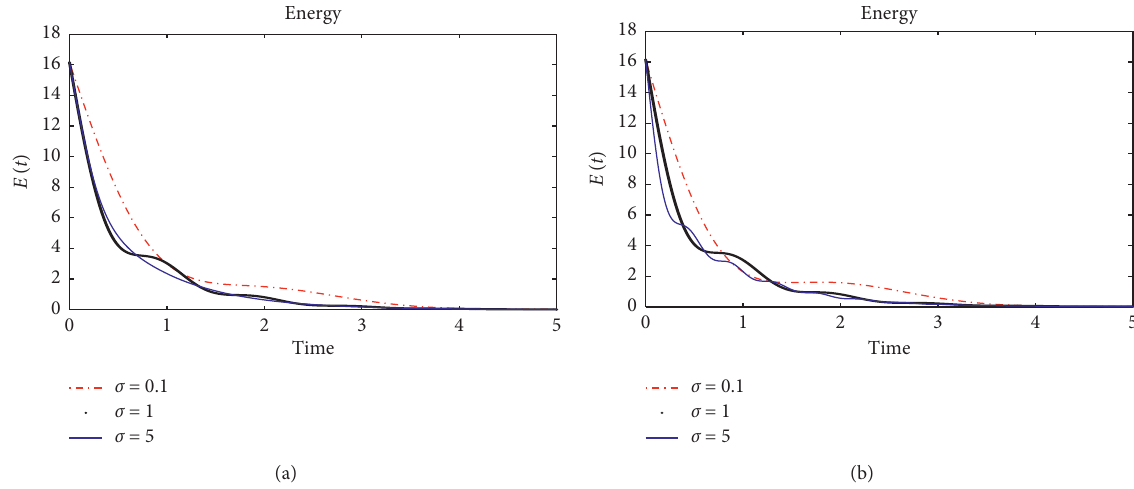
Figure 3: Energy decay for the exponential and the polynomial functions g polynomial function g